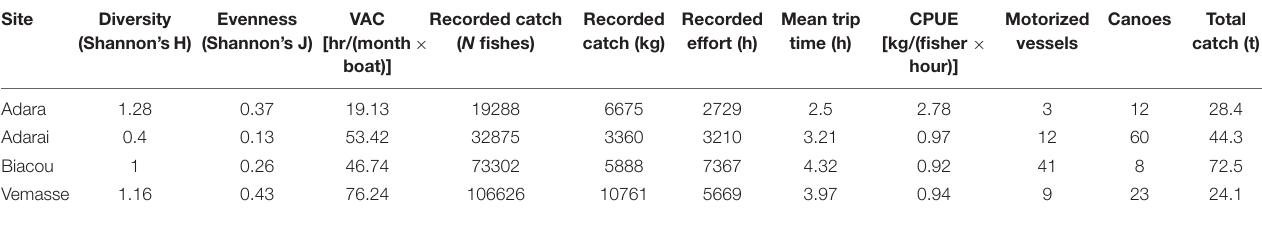
TABLE 2 | General catch statistics by landing site of four small-scale fishing communities in Timor-Leste. Site Diversity